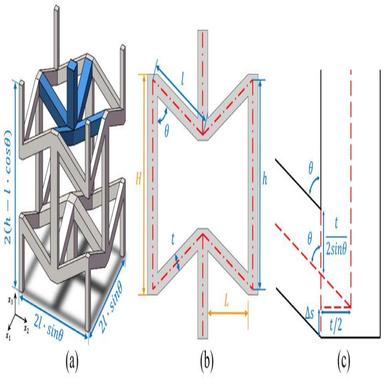
(a) Unit cell of the 3D re-entrant structure, (b) geometry parameters, (c) geometric relations at the joint node.